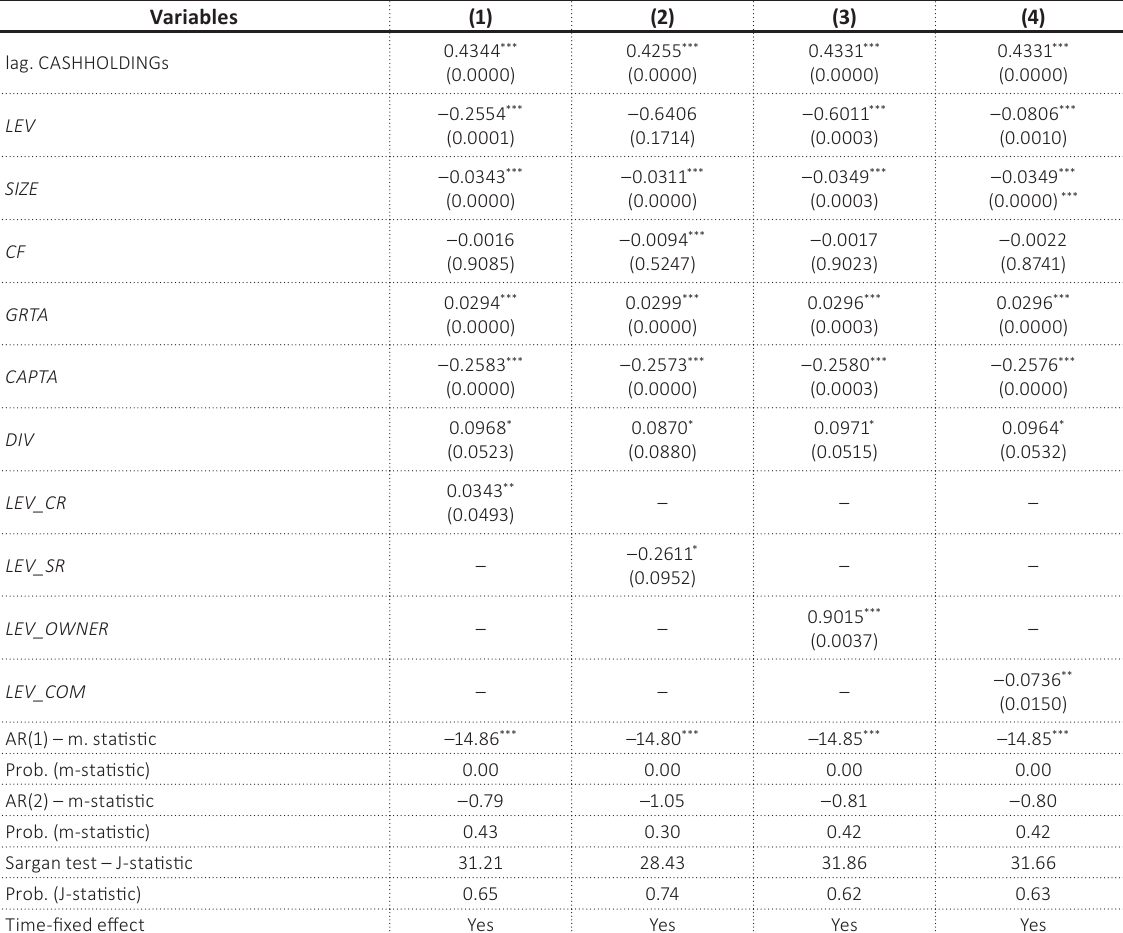
Table 9. Influence of debts on corporate cash holdings according to the legal-specific characteristics in a dynamic